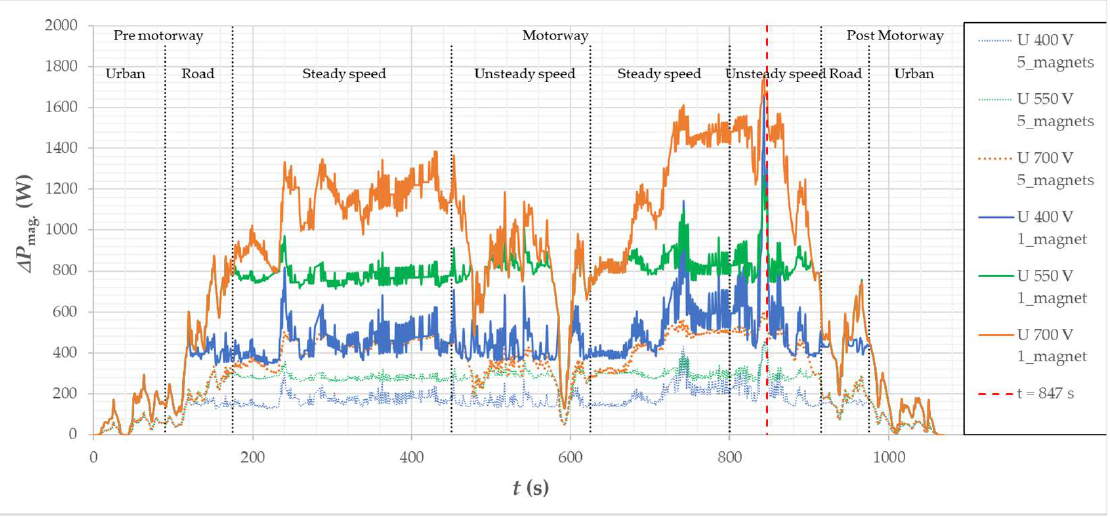
Figure 42. Calculated loss waveforms in magnets for three different supply voltages of the U DC drive, for a motor with magnet segmentation (×) and a motor without magnet segmentation .